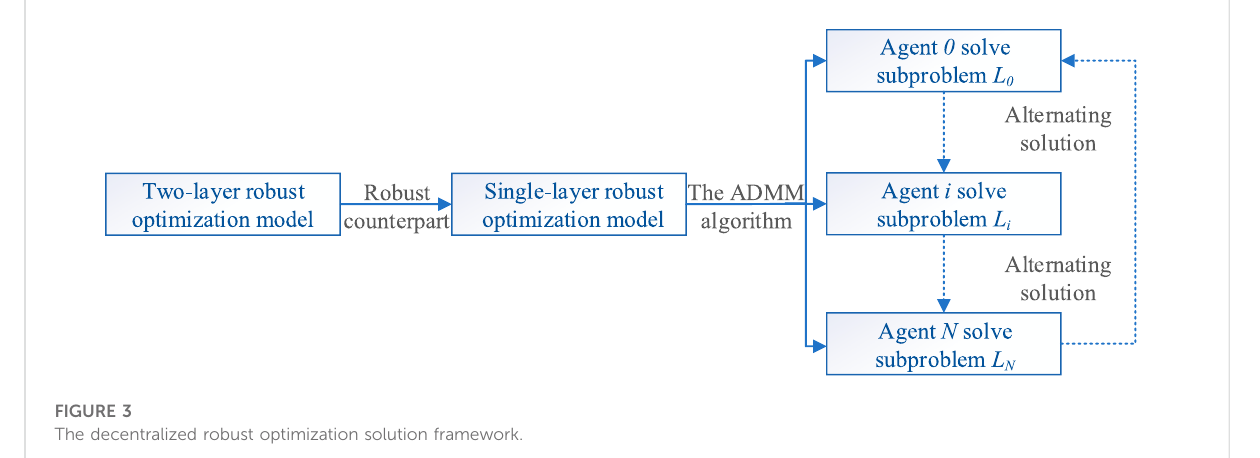
FIGURE 3 The decentralized robust optimization solution